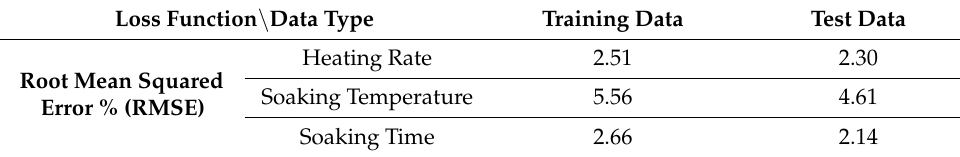
Table 12. Loss Function for Step 3.2.